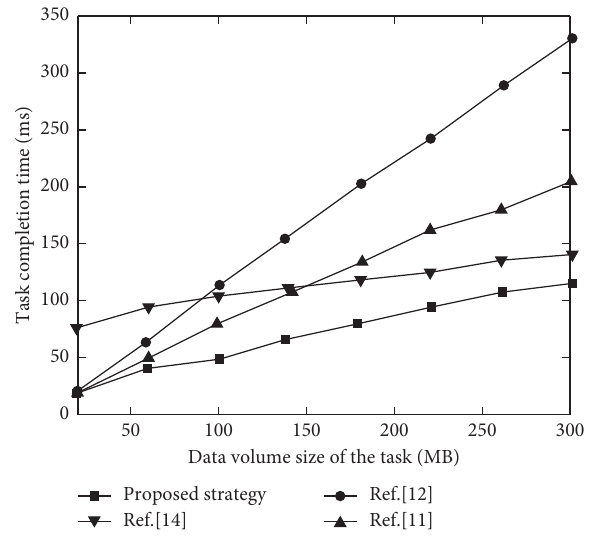
Figure 8: Relationship between application size and task com- pletion